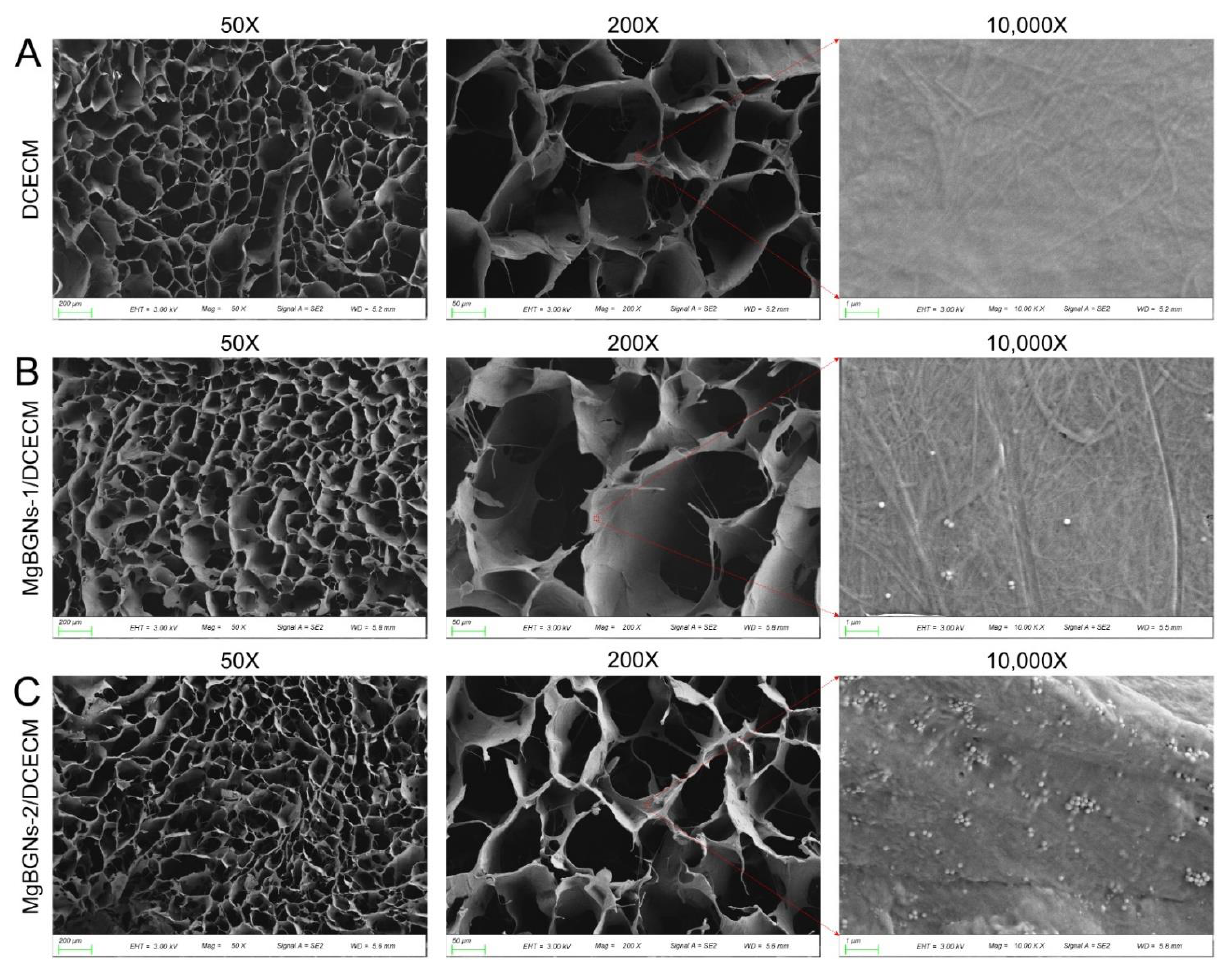
Figure 2. The microstructure of decellularized cartilage extracellular matrix (DCECM) and Mg-BGNs/DCECM scaffolds: ( A ) SEM images of DCECM scaffold; ( B ) SEM images of Mg-BGNs-1/DCECM scaffold; ( C ) SEM images of Mg-BGNs-2/DCECM scaffold.